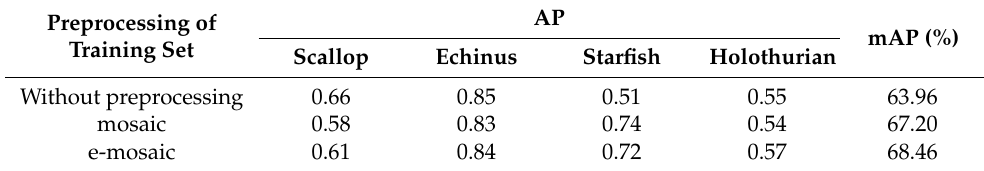
Table 1. Comparison of precision of recognition results with different preprocessing of training set.